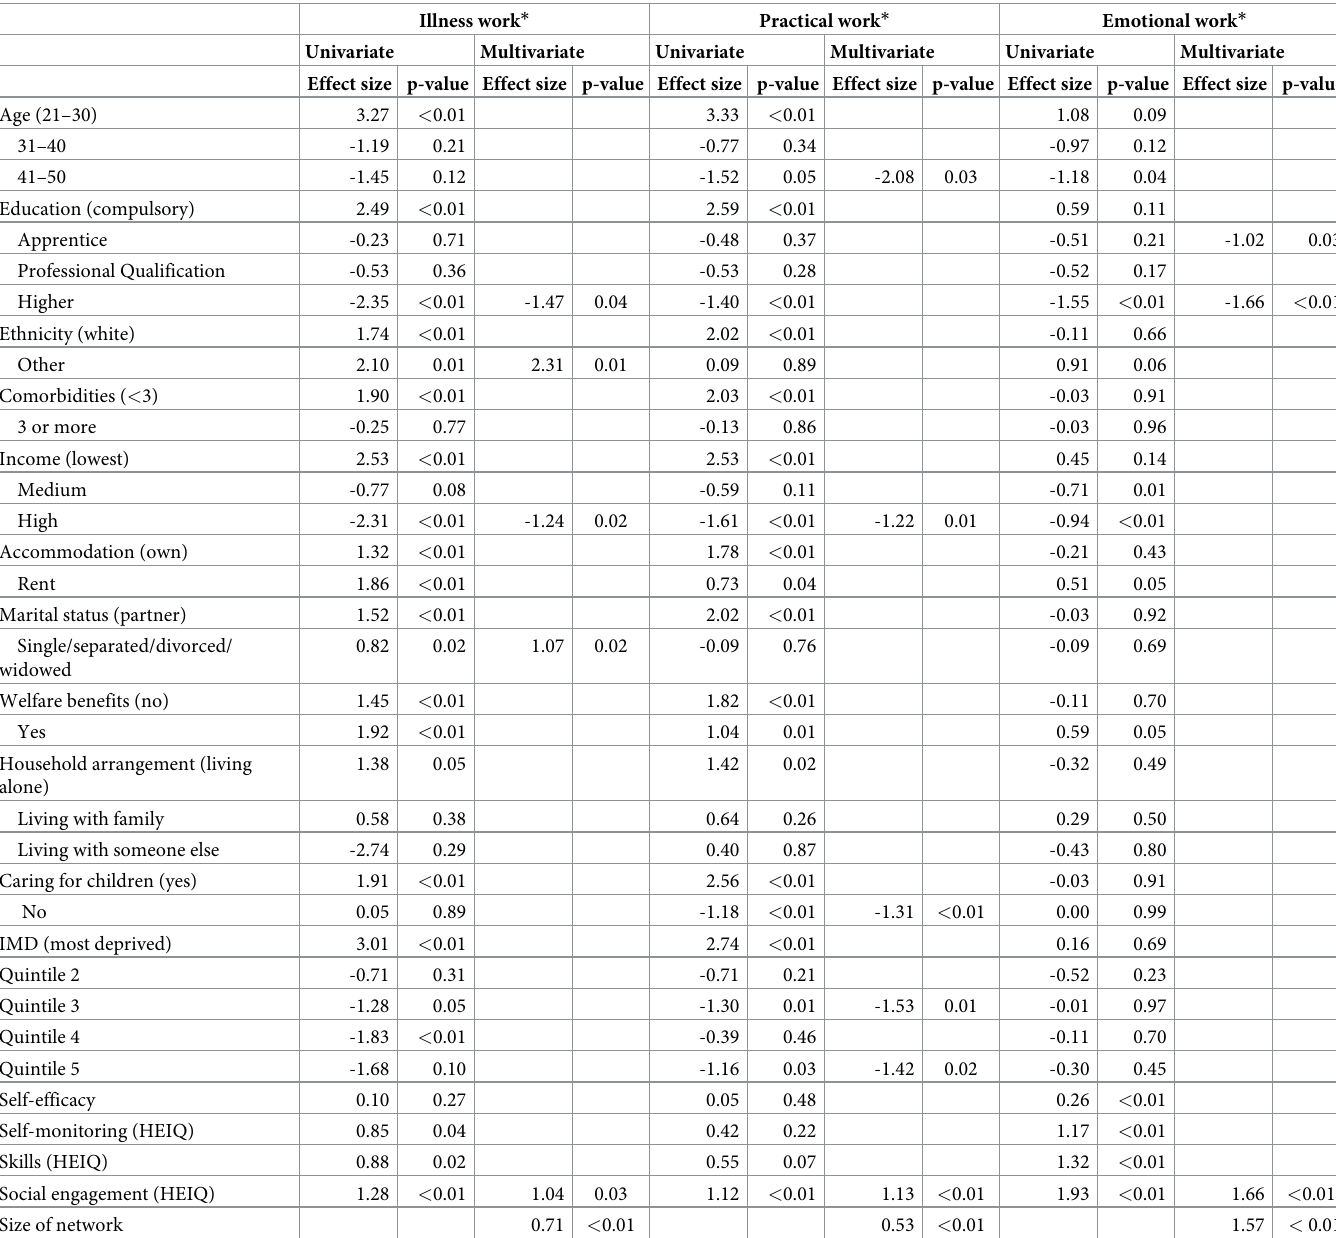
Table 3. Univariate and multivariate regressions of respondent level characteristics related to level of illness, practical and emotional support